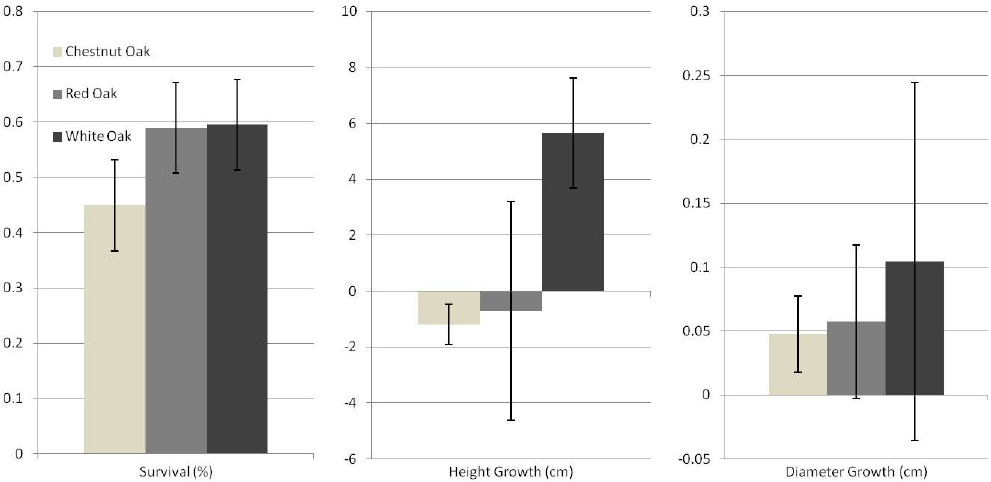
Figure 4. First-year growth and percent survival of white oak, chestnut oak, and northern red oak planted in pine-hardwood polyculture on rehabilitated mine land in eastern Kentucky.